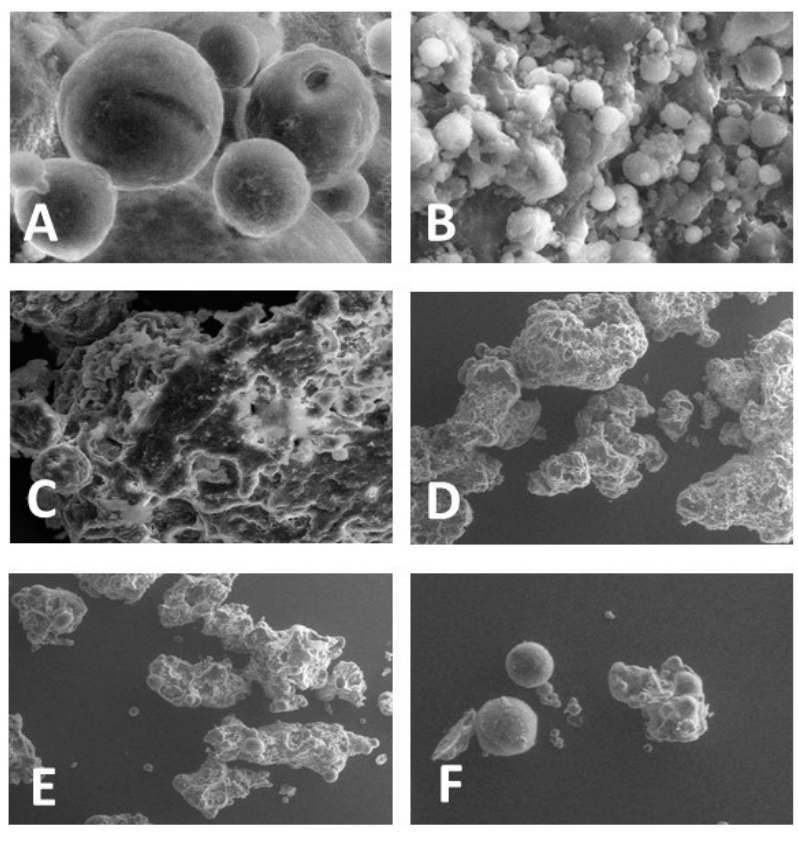
Figure 1. Variable-pressure scanning electron microscopy images (VPSEM) of LS TRIST ( A ), LS TRIST/TRIC ( B ), LS TRIST/AL30 ( C ), LS TRIST/AL15 ( D ), LS TRIST/AL10 ( E ), and LS TRIST/AL1 ( F ). Bar represents 20 µ m in panels ( A , B ), and 50 µ m in panels ( C – F ). LS acronyms are reported in Table 1.